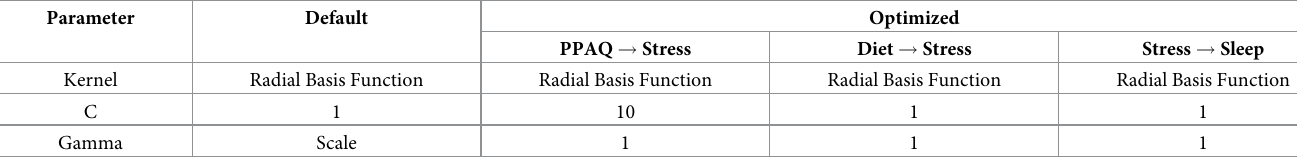
Table 2. Default and optimized parameters for each predictive model.